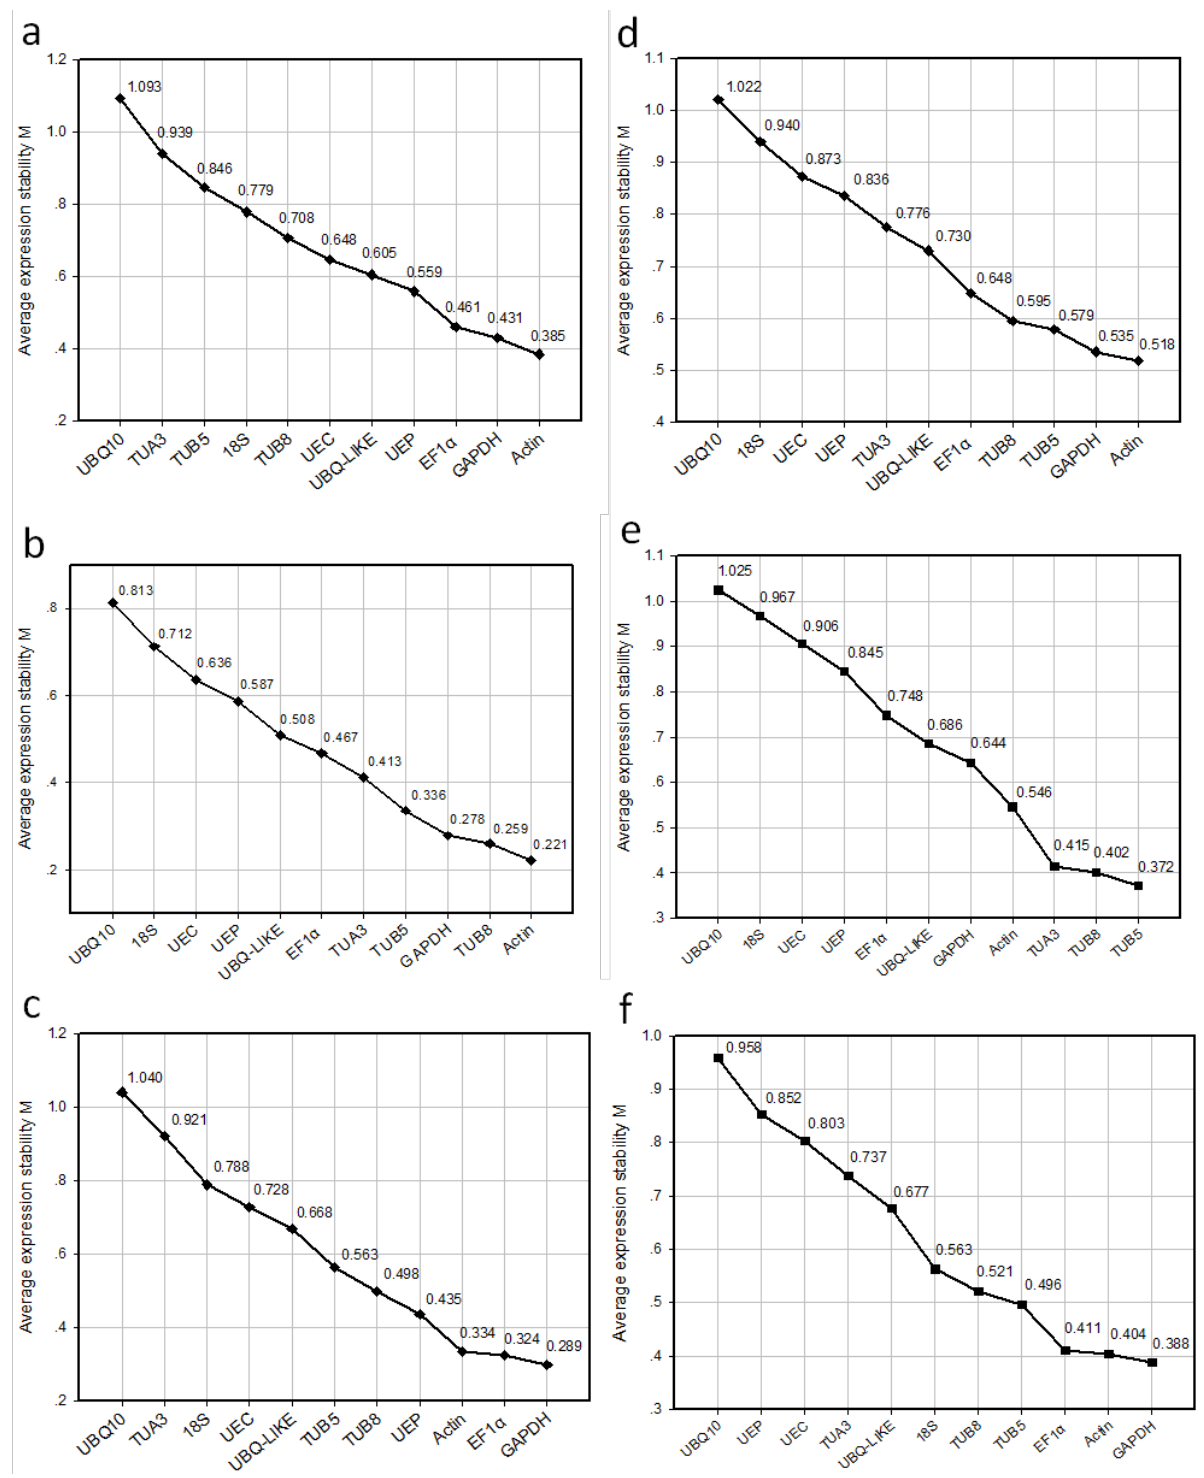
Figure 2. Expression stability values ( M ) and ranking of the candidate reference genes based on qBase PLUS calculations. ( a ) Two different developmental stages; ( b ) Vegetative stage; ( c ) Reproductive stage; ( d ) Desiccation and cold stress treatments; ( e ) Desiccation stress treatment; ( f ) Cold stress treatment. The M value and ranking were calculated through a pairwise comparison and stepwise exclusion of the least stable gene. Low M values correspond to a high expression